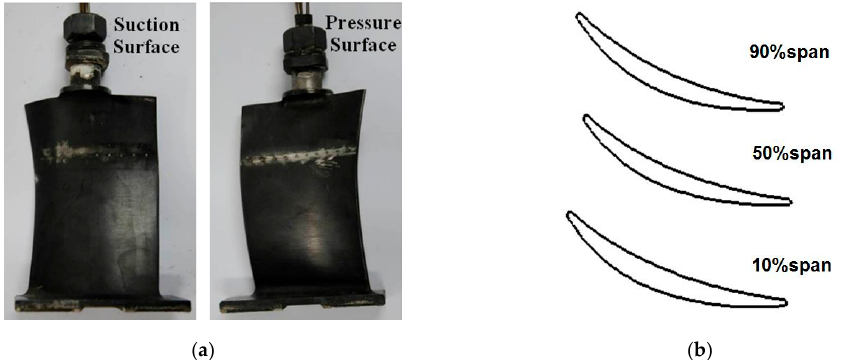
Figure 1. Schematic drawing of compressor test rig.